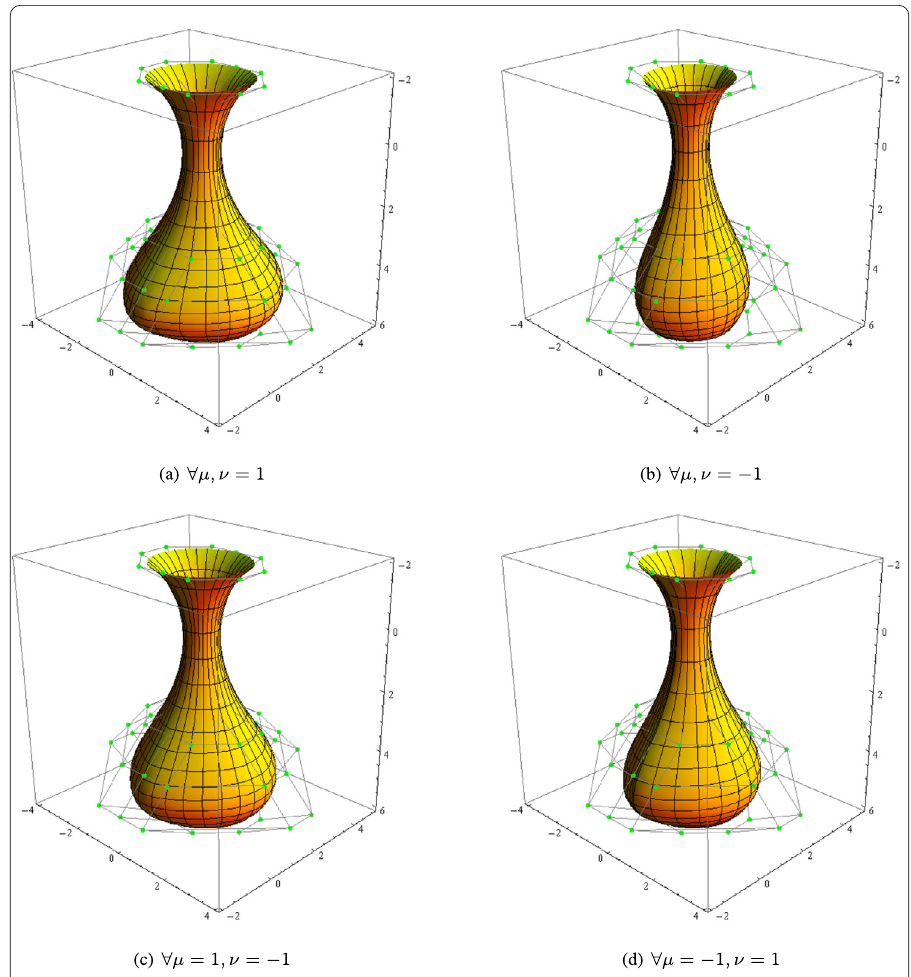
Figure 2 Effect of shape parameters on a GBT-Bézier surface